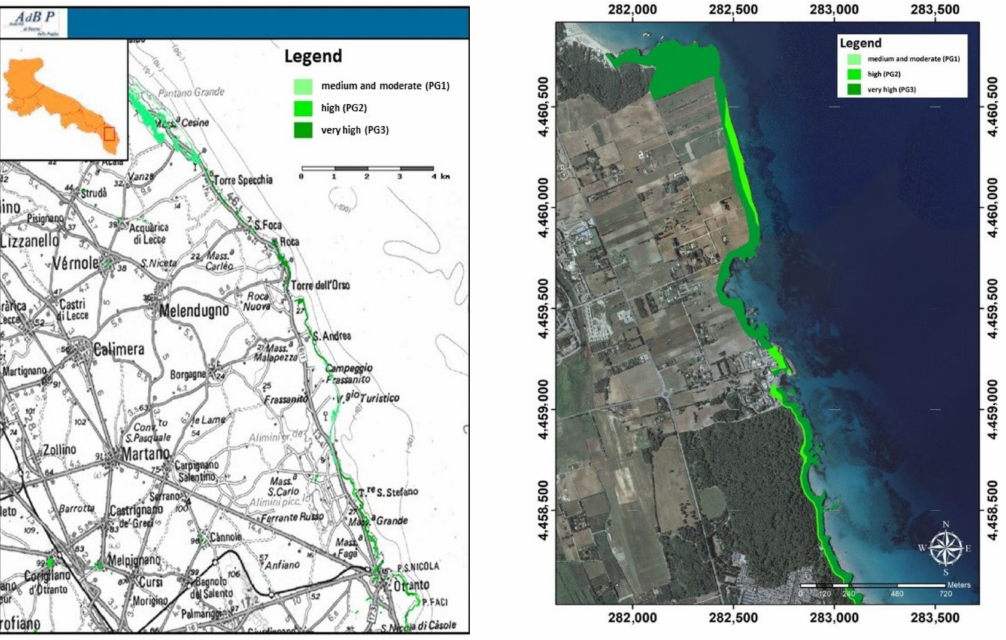
Figure 4. Thematic maps of geomorphological hazard